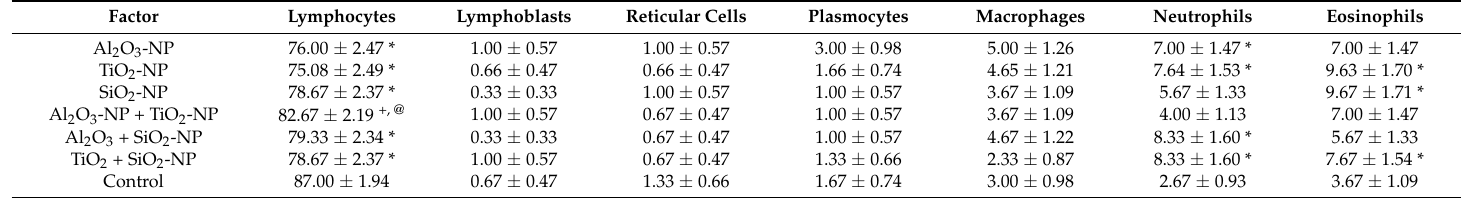
Table 11. Some Cytological Characteristics of Spleen Tissue Imprints as a Percentage of Total Cell Count in Rats after Subchronic Exposure to Al 2 O 3 -NP, TiO 2 -NP and SiO 2 -NP Individually or in Binary Combinations (x ±